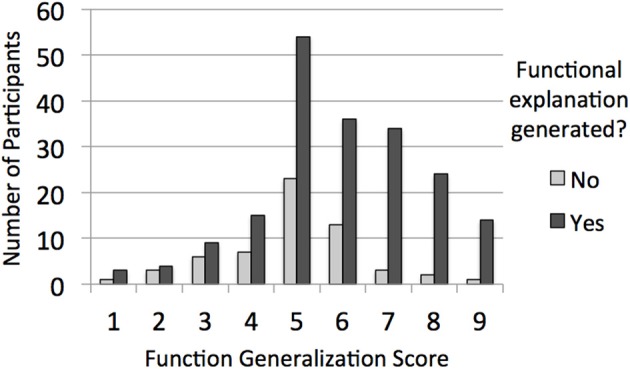
For Experiment 1, the distribution of function generalization scores as a function of whether or not the participant generated a functional explanation in response to the ambiguous explanation prompt.